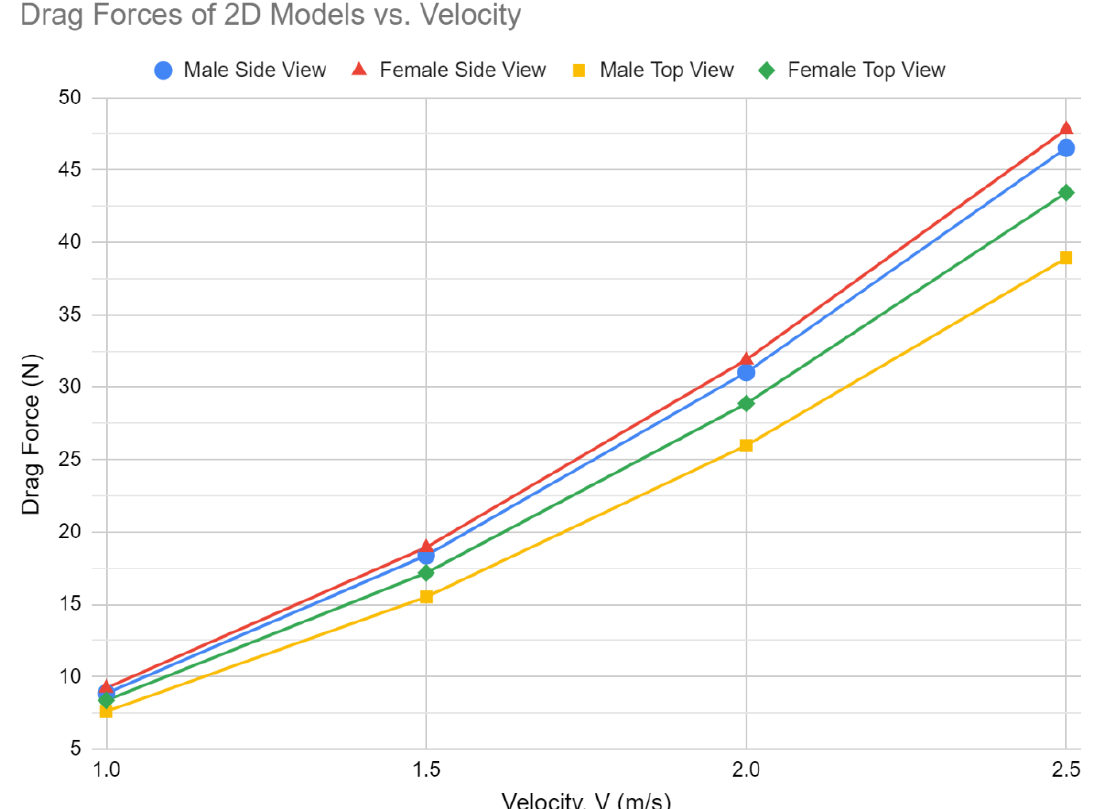
Figure 10. Graph of Drag Forces of 2D Models vs. Velocity.